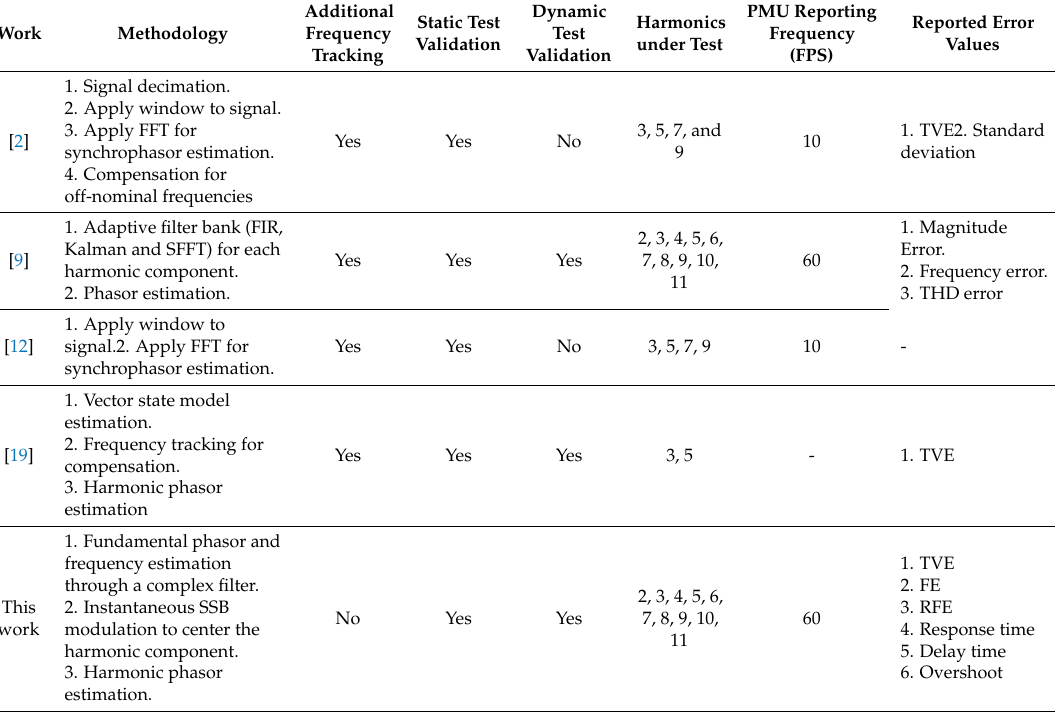
Table 3. Comparative summary between the proposed method and other related